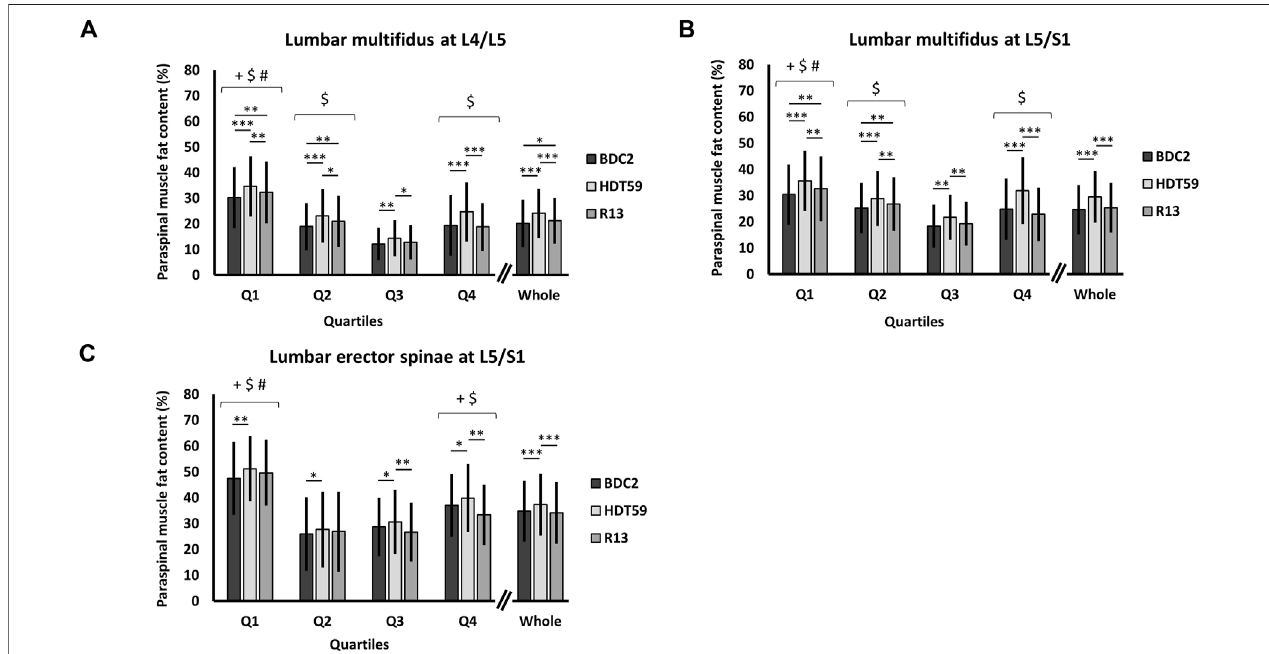
FIGURE3| Groupdata(mean±standarddeviation, n =24)ofparaspinalmusclefatcontent(%)inQ1,Q2,Q3,Q4,andwholemuscle2 daysbeforethebeginning ofthebed restperiod (BDC2),day 59ofhead-down tilt bed rest(HDT59), andday 13oftherecoveryperiod (R13).Theblack bar isBDC2, thelightgray bar HDT59,and thedarkgraybarR13. (A) Paraspinalmusclefatcontentinthelumbarmulti fi dusmuscleatL4/L5. (B) Paraspinalmusclefatcontentinthelumbarmulti fi dusmuscleatL5/ S1. (C) Paraspinal muscle fat content in the lumbar erector spinae at L5/S1. Main effect of Quartile: Pairwise comparisons (Bonferroni adjusted) + p < 0.05 compared with Q2; $ p < 0.05 compared with Q3; # p < 0.05 compared with Q4. Time*Quartile interaction: Pairwise comparisons (Bonferroni adjusted) * p < 0.05; ** p < 0.01; *** p < 0.001. BDC, Baseline data collection; HDT, Head-down tilt; R, Recovery.